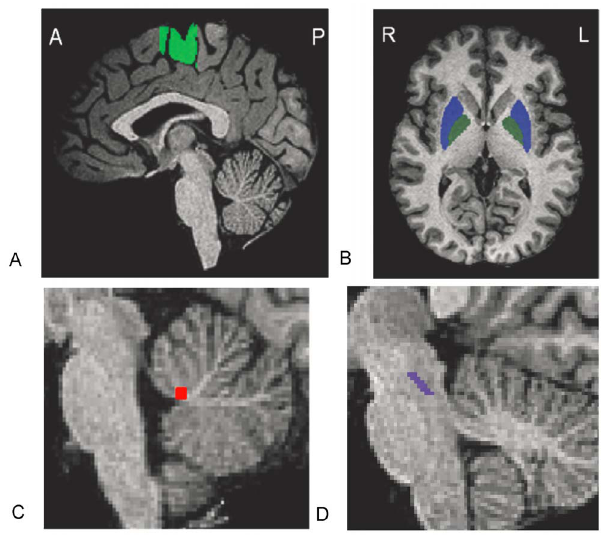
Figure 2. Regions of interest. Regions were identified for each individual separately based on standard definitions (see Methods). Shown are examples of regions defined for four subjects: supplemen- tary motor area (a), putamen and globus pallidus (b), cerebellar locomotor region (c), and mesencephalic locomotor region (d). A- Anterior; P-Posterior; R-Right; L-Left.